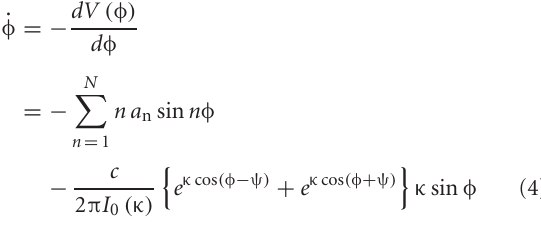
Frontiers in Human